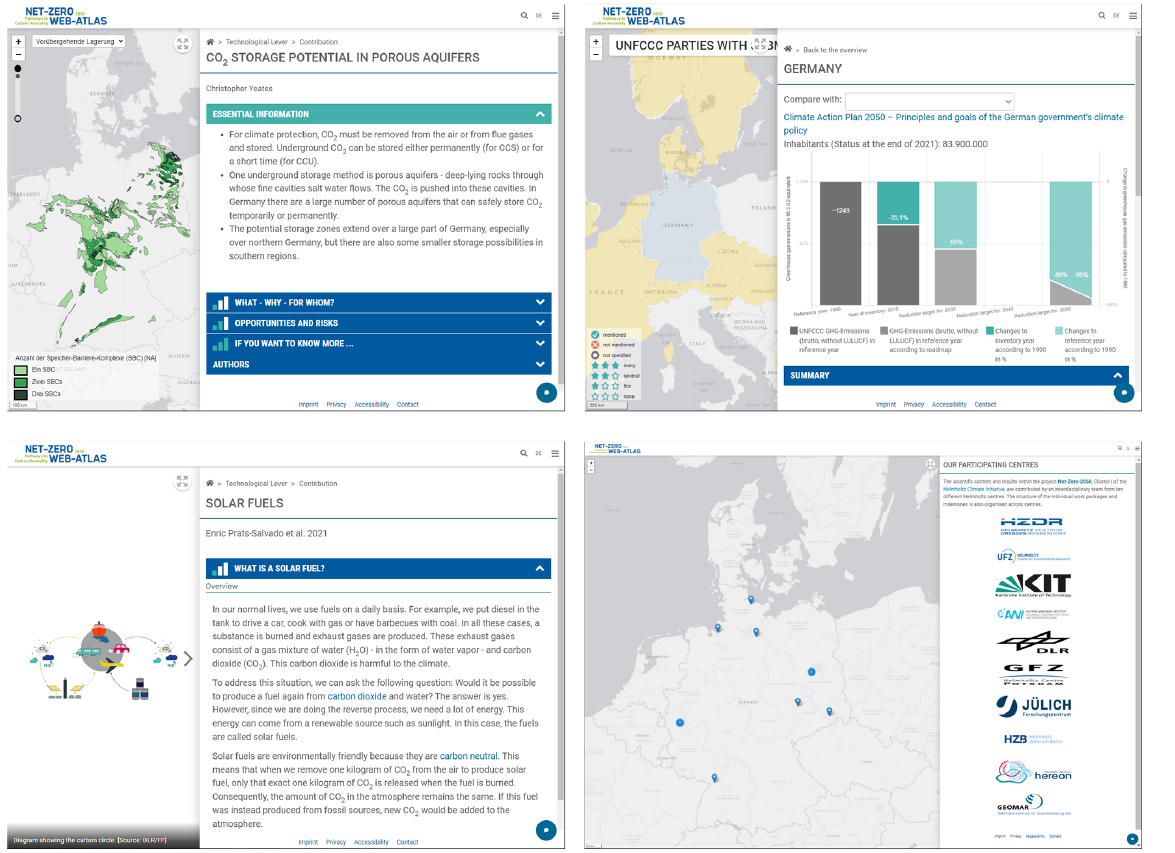
Figure 6. Screenshots of the Net-Zero-2050 Web-Atlas contributions: exemplary map contribution (upper left – Yeates, 2022); exemplary story contribution (lower left – Prats-Salvado and Monnerie, 2022); exemplary UNFCCC roadmap synthesis (upper right – UNFCCC- Roadmaps, 2022); our partner centres (lower right – Net-Zero-2050 Participating Centres,